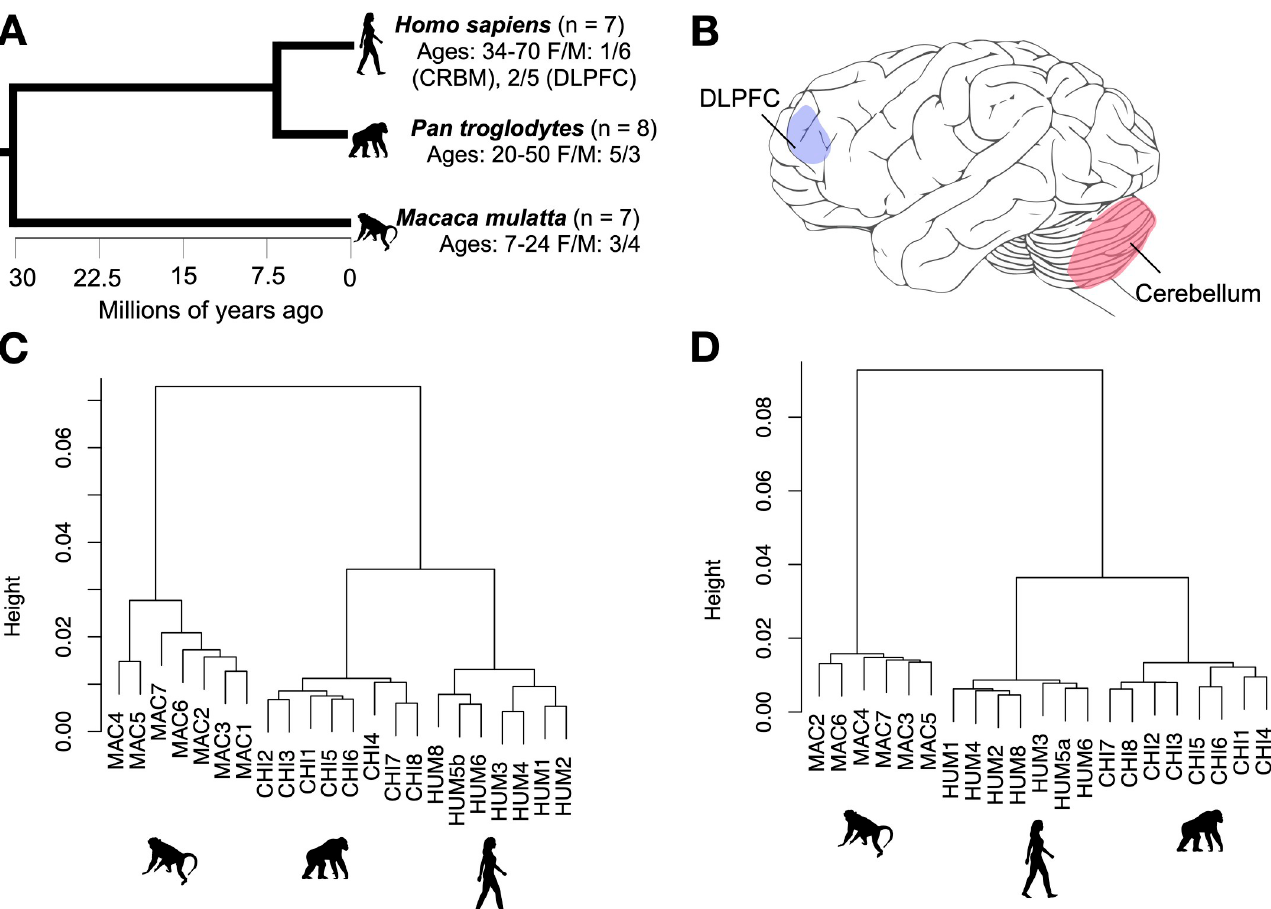
Fig 1. Species relationships, brain structures, and sample clustering. A = Phylogenetic tree of species included in this study from TimeTree.org [113], B = brain structures included in this study depicted on a chimpanzee brain illustration modified from [114], C and D = hierarchical clustering of samples from the dorsolateral prefrontal cortex (C) and cerebellum (D) based on genome-wide methylation after filtering and normalizing using correlations between samples as distance. DLPFC = dorsolateral prefrontal cortex.